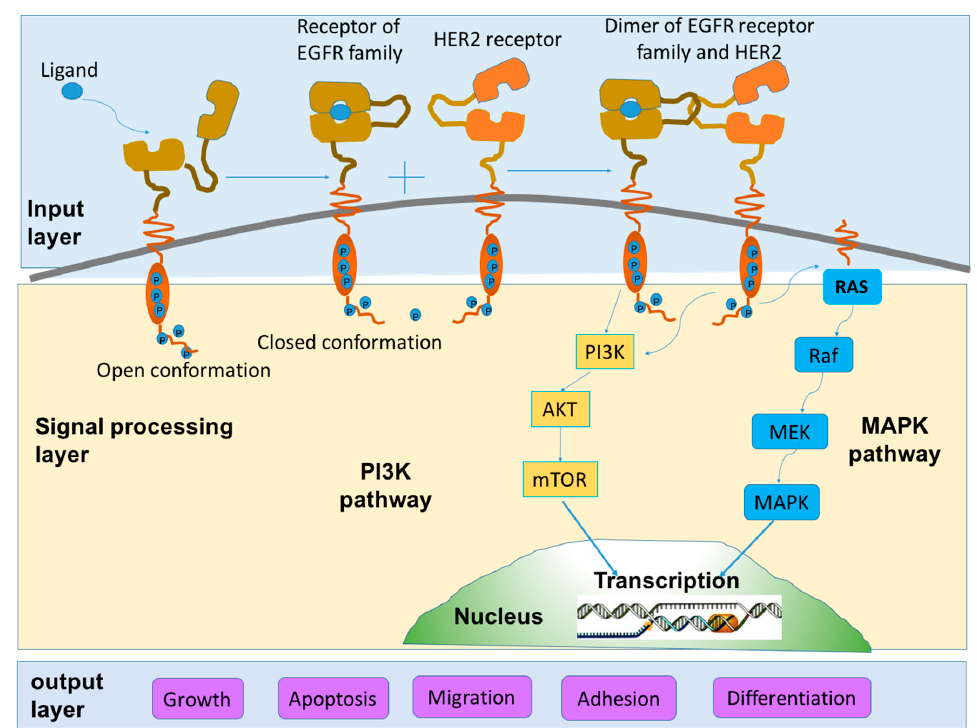
Figure 2. Schematic diagram of HER2 signaling pathways. Upon ligand binding, dimerization between receptors of EGFR family and HER2 receptor is induced. The homodimers or heterodimers thereafter stimulate a serial of signaling cascades. Among various signaling pathways, the phosphatidyl inositol 3-kinase (PI3K) and mitogen-activated protein kinase (MAPK) pathways are the two major and most studied pathways which take a pivotal role in tumor proliferation and anti-apoptosis. The whole signal transduction process can be divided into three sections: signal input (ligand-binding and dimerization), signal processing (a series of signaling cascades) and signal output (corresponding cellular processes). The scheme is modified based on two works contributed by Yarden et al. [15] and Tai et al. [16], respectively.